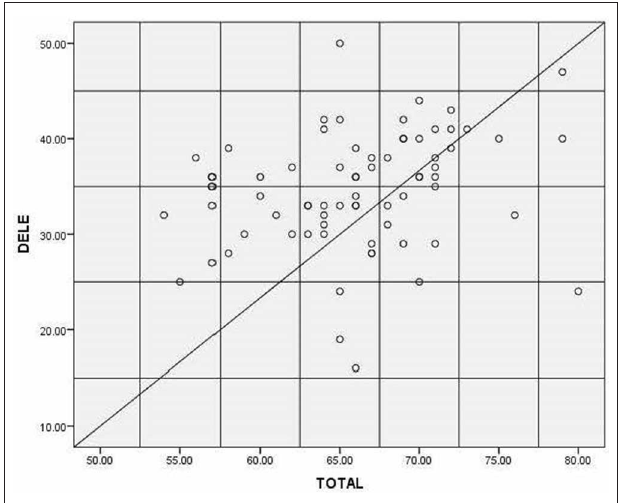
spelling of the target letter. Other spelling errors were ignored.